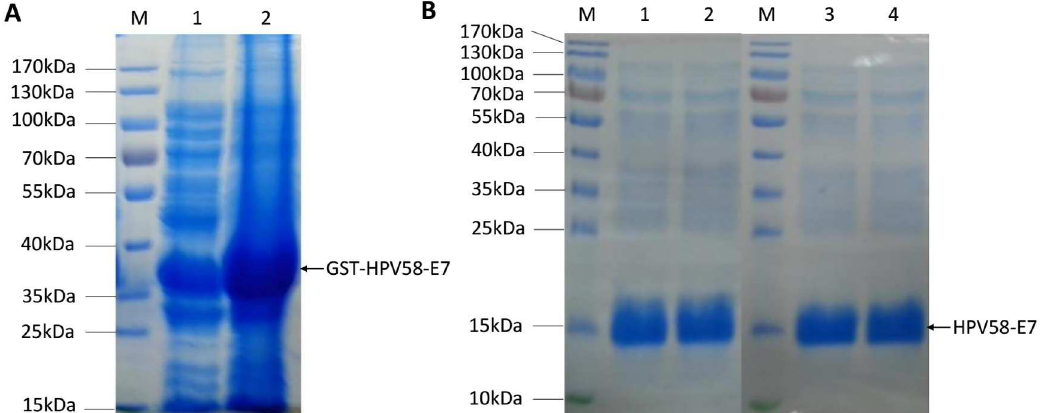
Fig 2. Expression and purification of HPV58E7 protein. (A) Coomassie bluestainingfor recombinant GST-HPV58-E7 protein.LaneM is the proteinladder;Lane2 shows the proteinof the supernatant of the bacterial lysateafter centrifugation; Lane3 shows the proteinof the sedimentof bacterialysate. The arrowheadindicatesGST-HPV58-E7 protein.(B) Coomassie bluestainingfor purifiedHPV58-E7protein.LaneM is the proteinladder;Lane1 and 2 show the purifiedE7 proteinafter removalof GST-tag; Lane3 and 4 show the E7 proteinafter dialysisin PBS. The arrowheadindicates